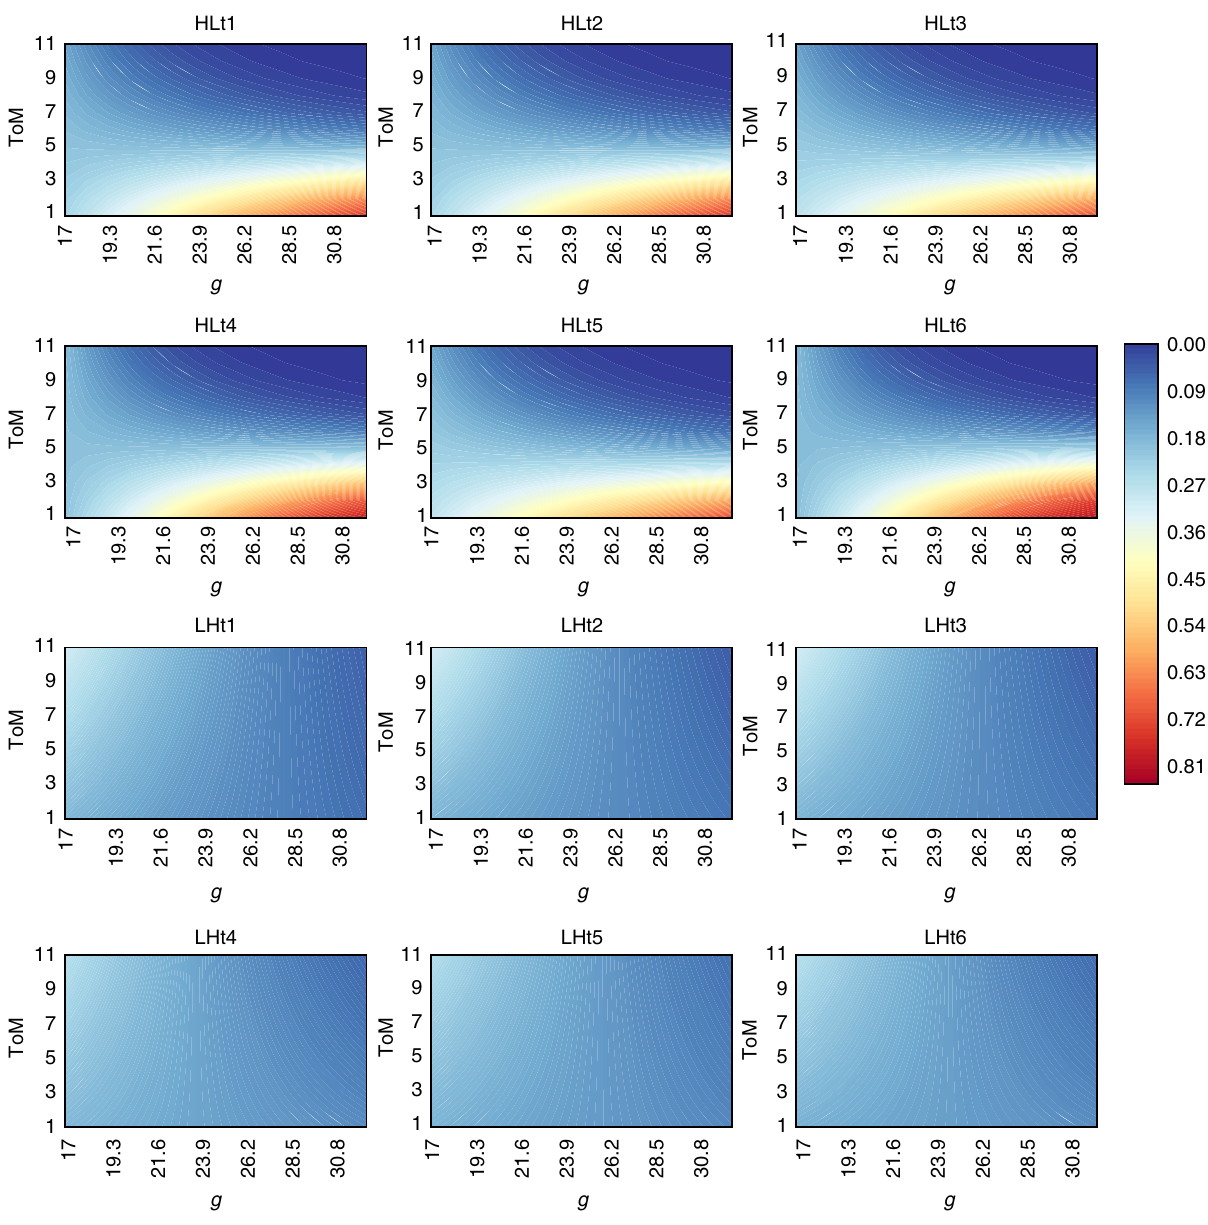
Fig. 2 Effects of g and ToM on Time. Blue color = group harvested for more time (i.e. did not or collapsed the resource later). LH low-to-high resource growth treatment, HL high-to-low resource growth treatment. The different fi gure panels represent the marginal effects of g and ToM for the different models portrayed in Supplementary Table